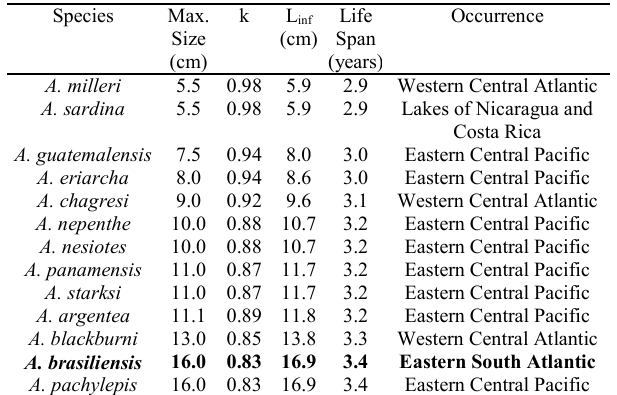
Table 1. Growth parameters, life span and occurrence of species of the genus Atherinella. Data compiled at FishBase (Froese & Pauly, 2007) using only species with growth data available.